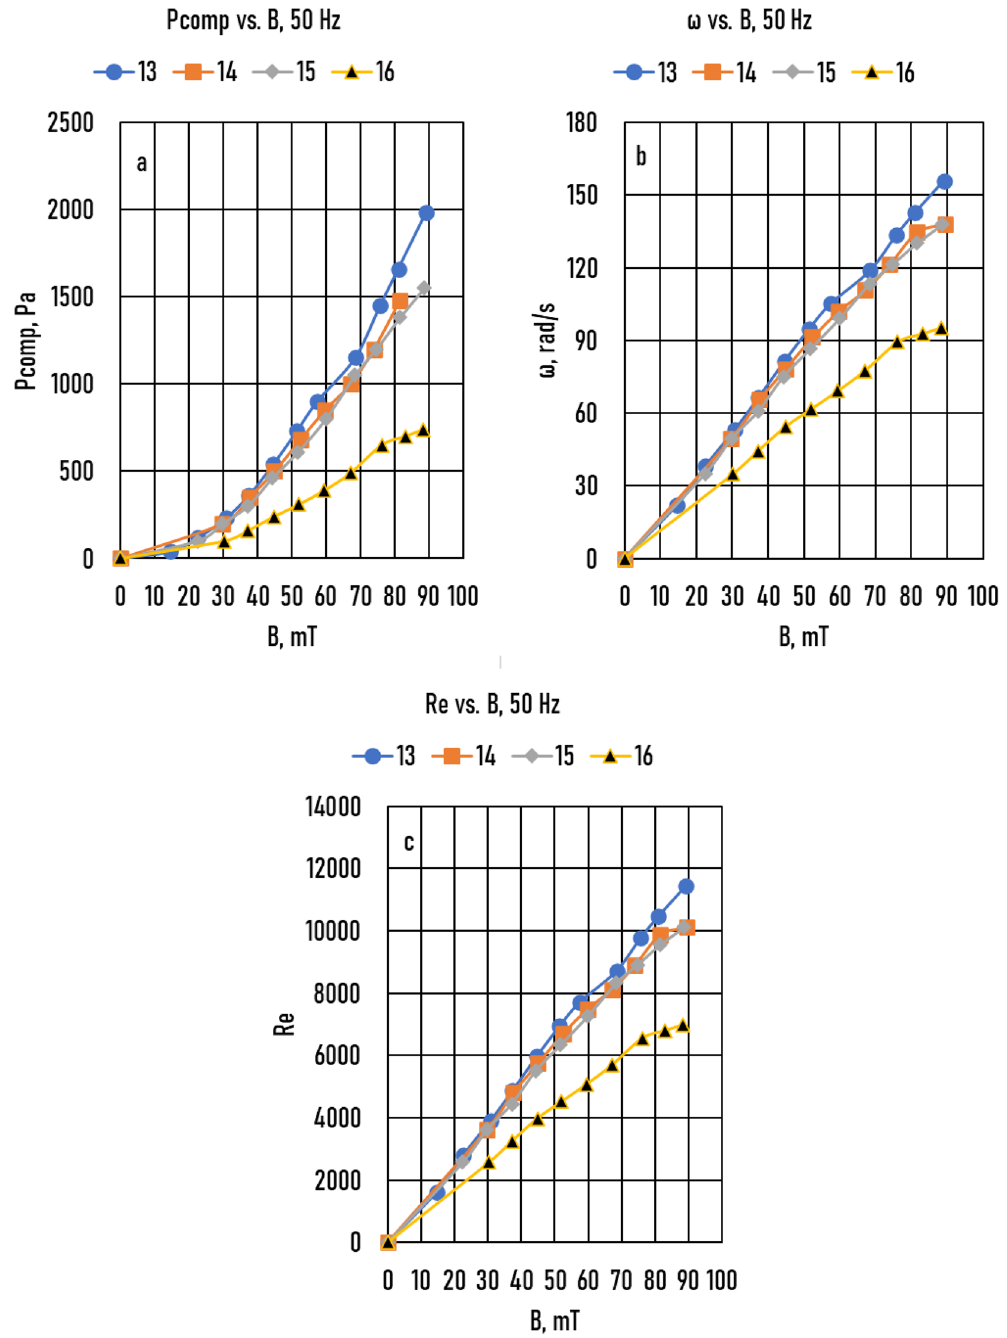
Figure 6. Samples 13 – 16 ( a ) Measured compensation pressure ( P comp ) as a function of magnetic induction ( B ). ( b ) Angular frequency of melt ( ω ) as a function of B . ( c ) The real Reynolds number ( Re ) as a function of B